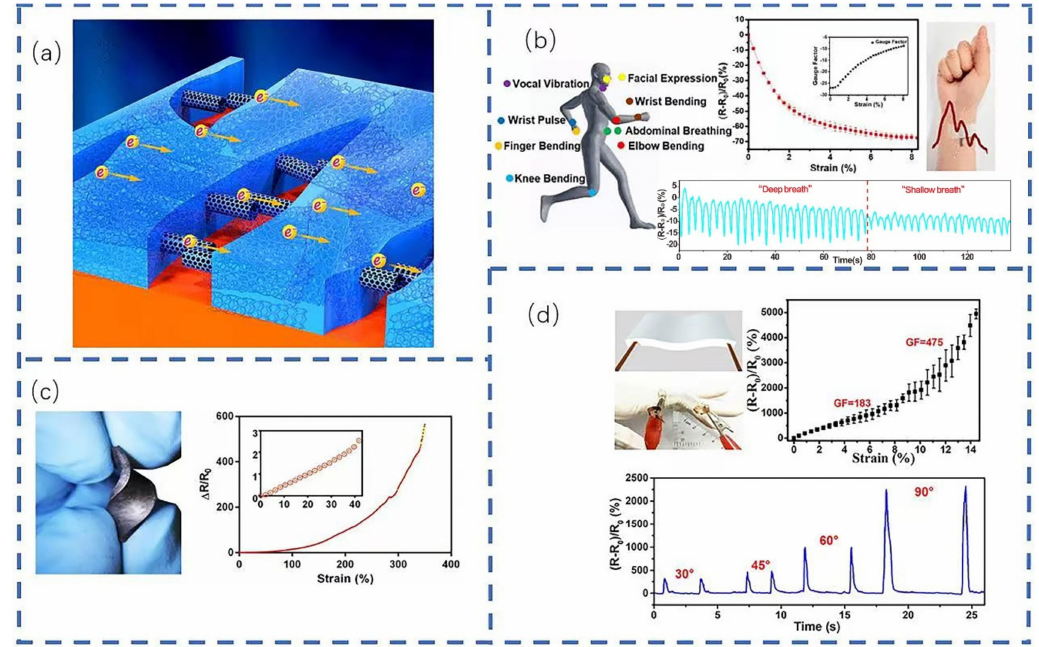
Figure 4. Application of the strain-based flexible sensor in smart wearables: ( a ) a schematic diagram of electron transport at the crack edge in a crack-flexible strain sensor [43]; ( b ) a wearable graphene fabric strain sensor for the detection of various human motions [44]; ( c ) injection of graphene nano-powders into transparent adhesive pads to fabricate flexible strain sensors with an excellent tensile–strain response [45]; and ( d ) the sensory performance in response to the bending of the finger and the degree thereof are both reflected in the relative rate of change in the resistance